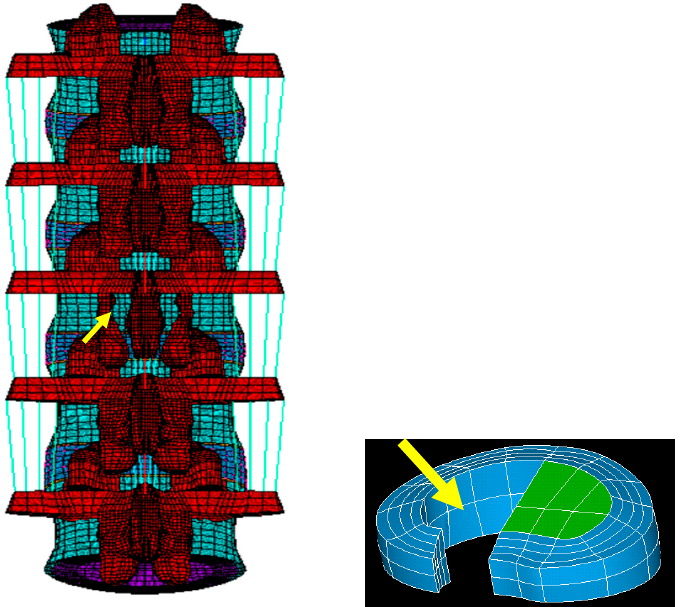
Figure 2. Defect model of the lumbar spine. The L3–L4 disc was partially removed from the ground substance and nucleus. The posterior element at the L3 level was also partially removed. Note: the arrow indicates the location of removed parts.